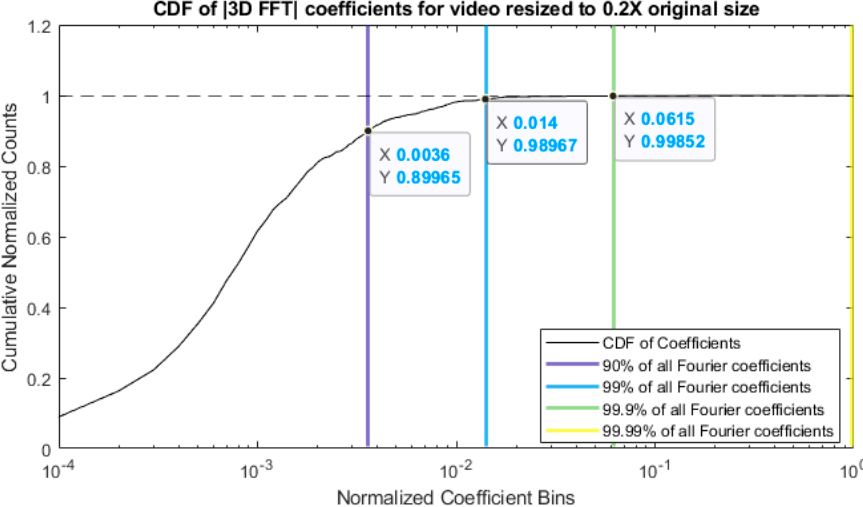
Figure 8. Cumulative density function of the normalized 3D Fourier coefficients of the vibrating cantilever beam video.